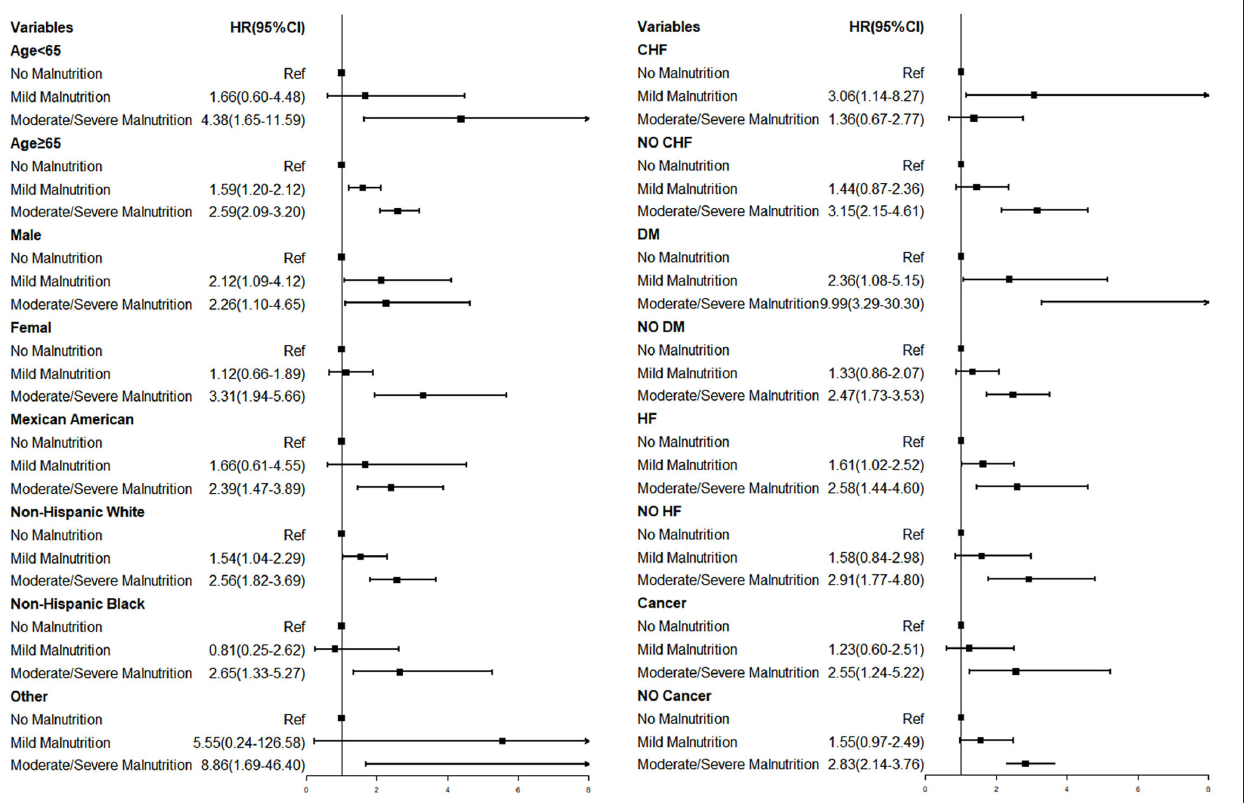
FIGURE 4 | Forest plot of overall survival in subgroups. CI, confidence interval; HR, Hazard